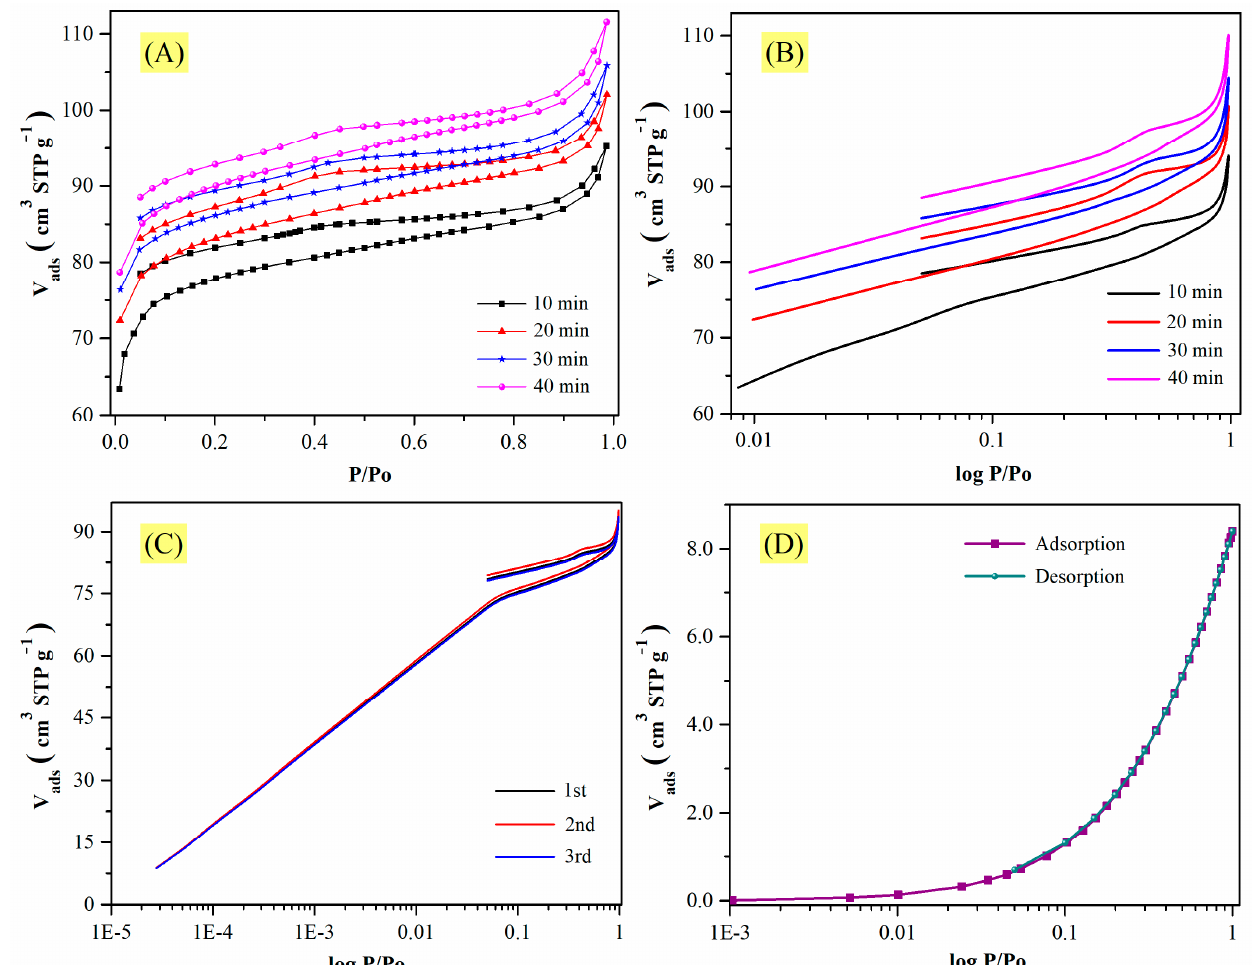
Figure 6. Nitrogen isotherms of CMF-600. At − 196 °C and different equilibration times in ( A ) linear and ( B ) logarithmic scales. ( C ) It was repeated 3 times with an equilibration time of 10 min at − 196 °C. ( D ) Equilibration time: 10 min at 0 °C.